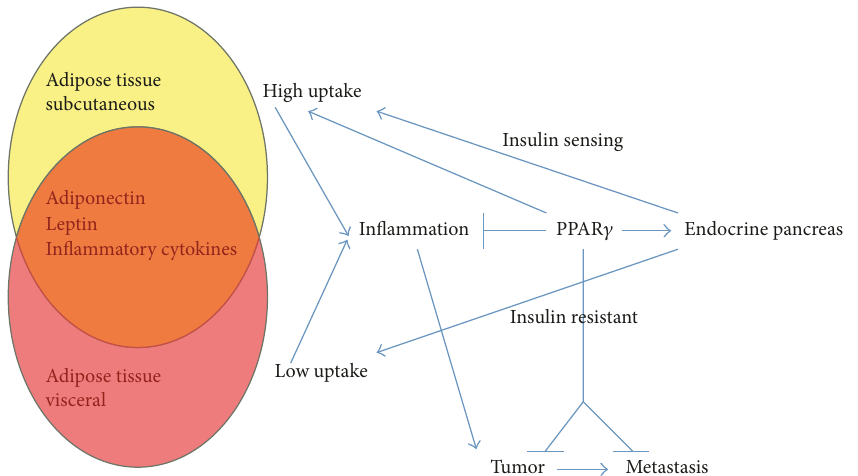
Figure 1: Effects of peroxisome proliferator-activated receptor- 𝛾 on diabetes, obesity, and pancreatic ductal adenocarcinoma [5].